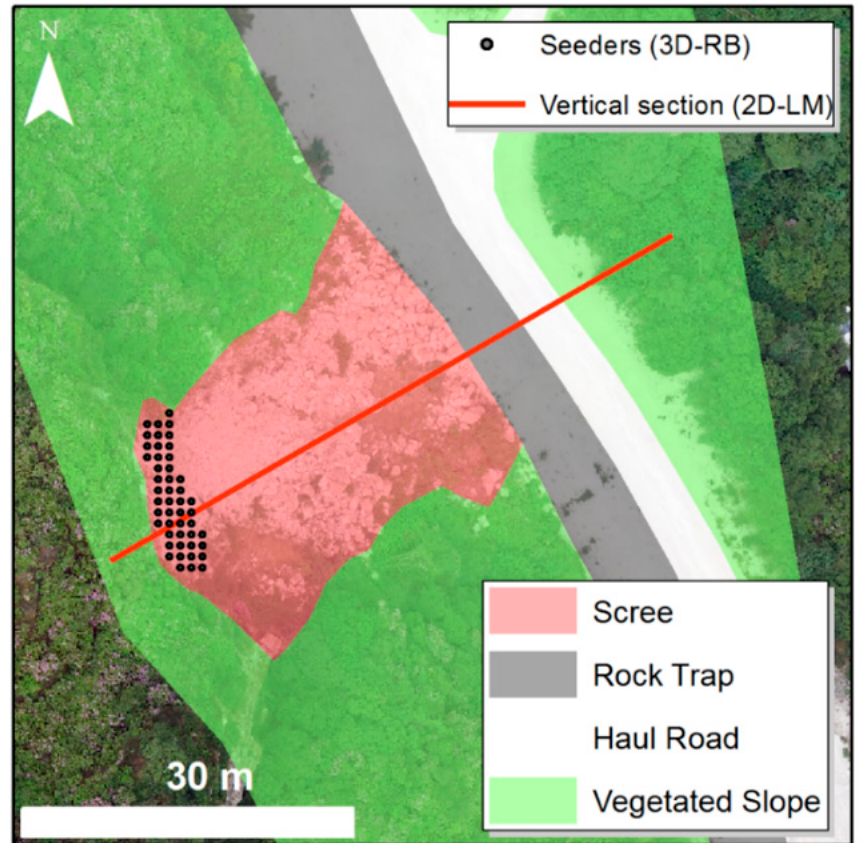
Figure 6. Geo-mechanical zonation used to assign input parameters for the 3D numerical modelling. In red is shown the trace of the representative vertical profile extracted from the Digital Elevation Model (DEM) to obtain the slope geometry for 2D numerical modelling.